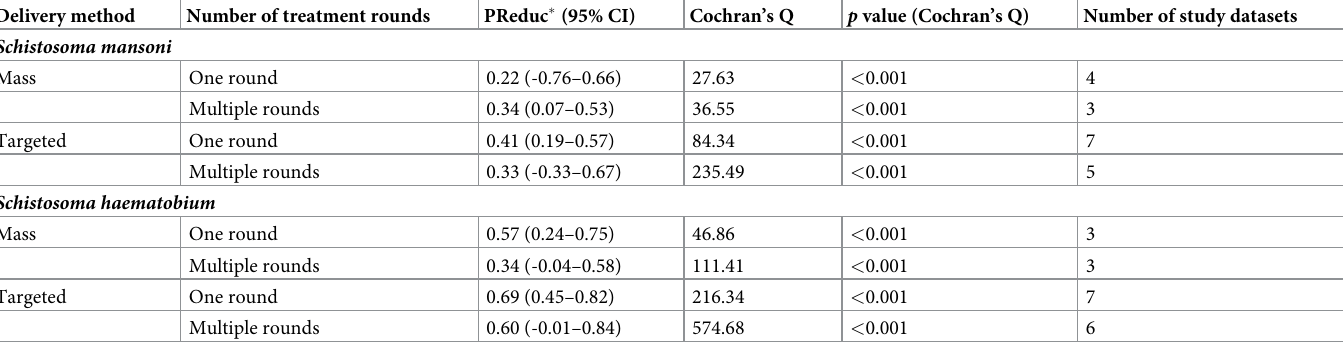
Table 4. Meta-analysis results showing pooled prevalence reduction estimates (non-truncated), shown for mass and targeted studies for each schistosome species, stratified by number of treatment